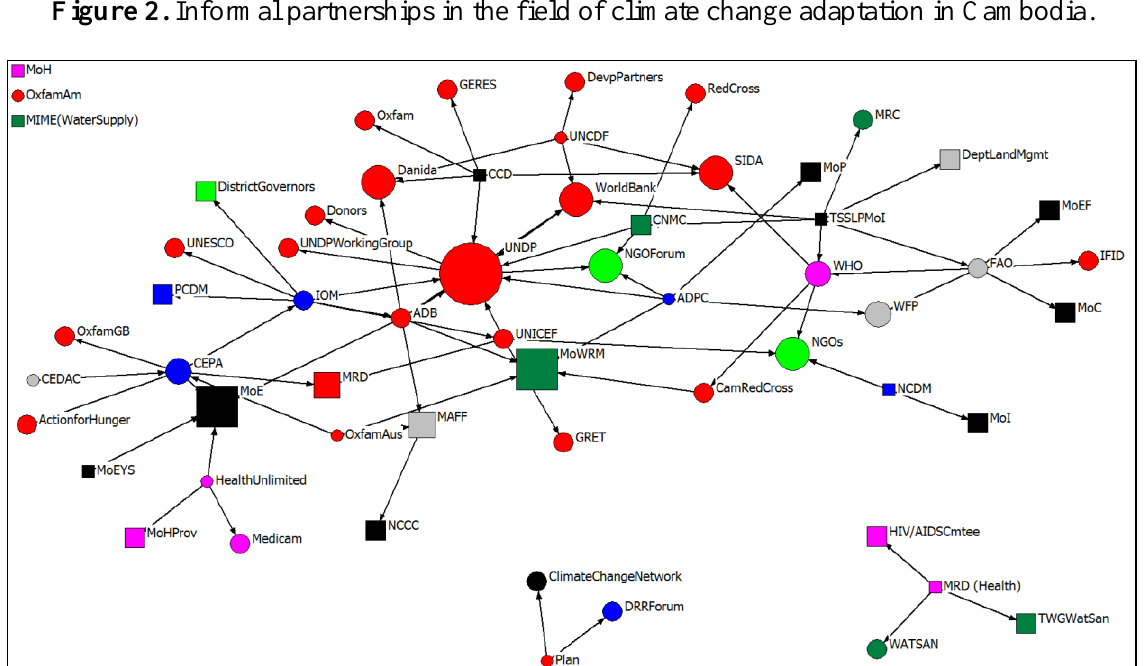
Figure 2. Informal partnerships in the field of climate change adaptation in Cambodia.